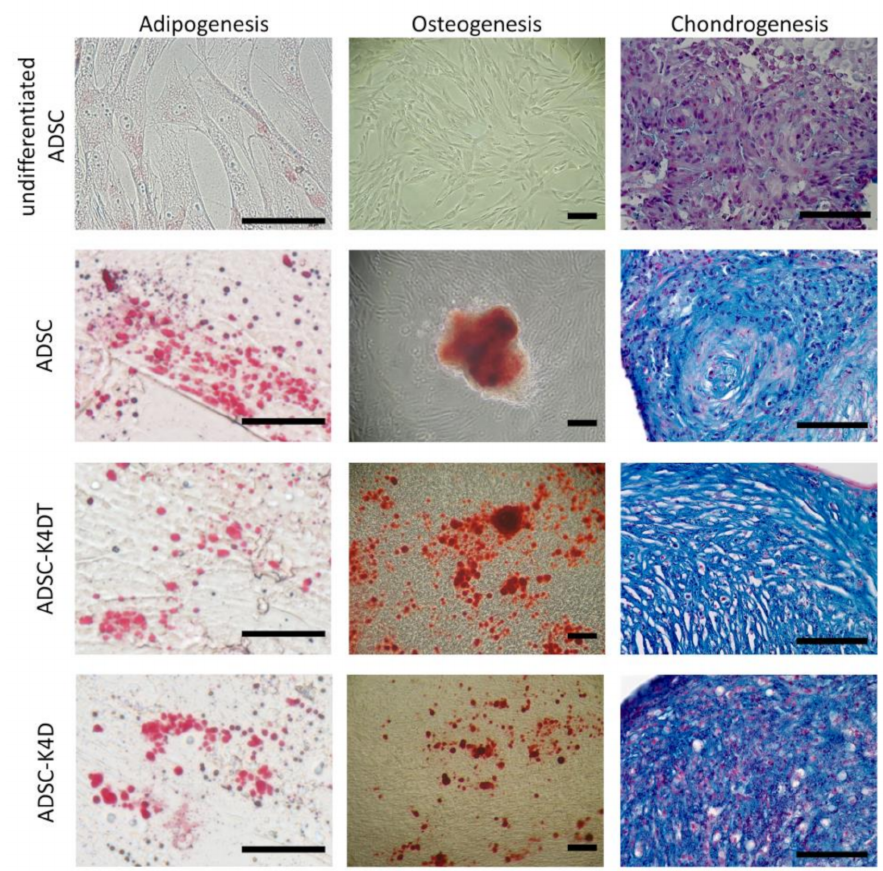
Figure 5. Trilineage differentiation potential of the ADSC-K4DT and ADSC-K4D cells. Adipocytes, osteocytes, and chondrocytes were induced from the ADSCs at passage 3, and the ADSC-K4DT and ADSC-K4D cells at approximately PDL 100 by each differentiation culture method and stained with oil red O, alizarin red, and Alcian blue, respectively. Bar = 100 µ